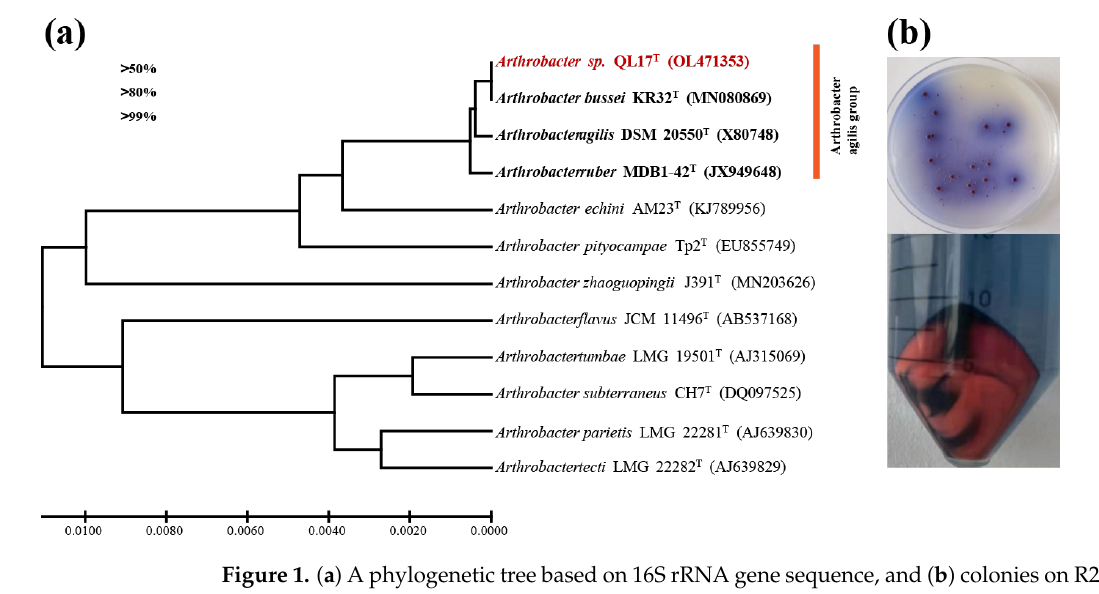
Figure 1. ( a ) A phylogenetic tree based on 16S rRNA gene sequence, and ( b ) colonies on R2A medium and liquid culture of Arthrobacter sp. QL17.